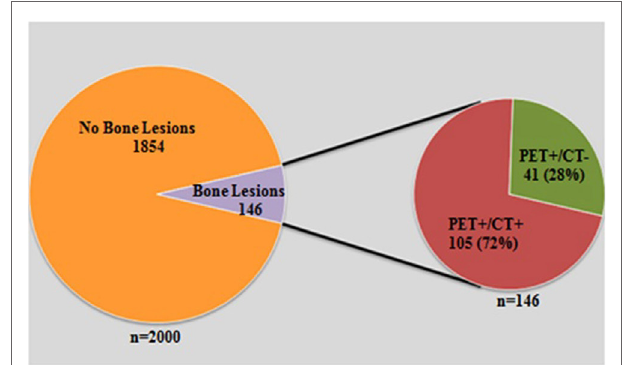
FigUre 1 | a graph demonstrated total number of scans that were reviewed 2000 . Of those, 146 had suspected SM by PET and CT. However, 41 cases were only positive by